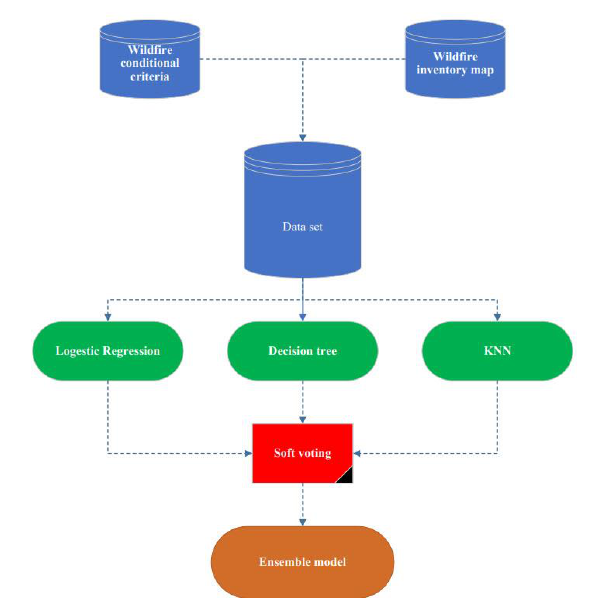
Figure 2 . The flowchart signifies the introduced approach for forest fire susceptibility modelling and